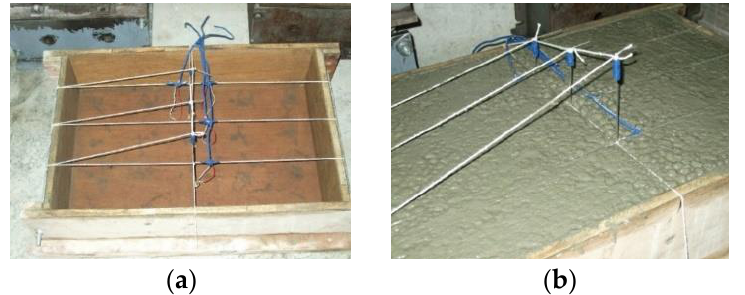
Figure 2. Installation of thermocouples and pressure gauges in the slab specimens: ( a ) before pouring and ( b ) after pouring.